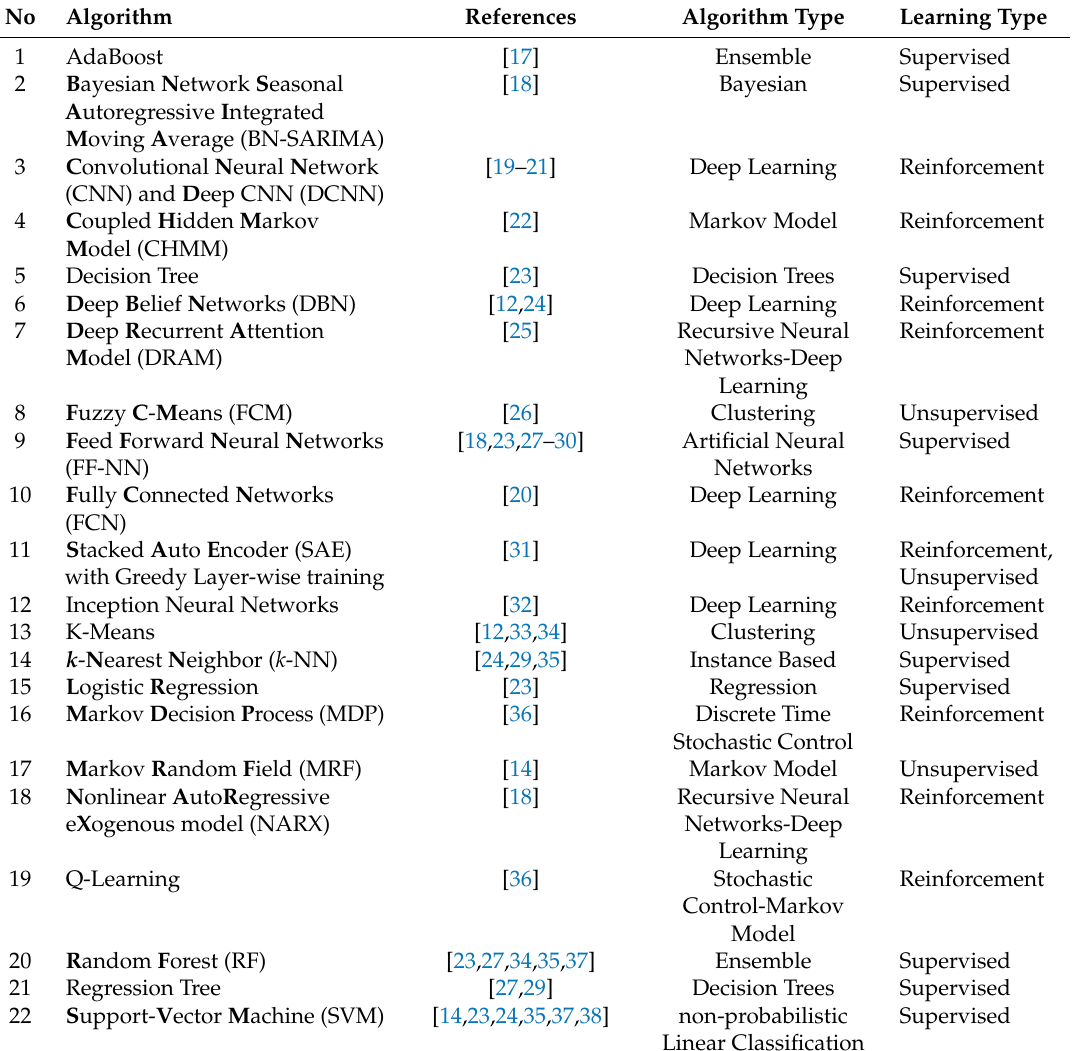
Table 1. Machine Learning algorithms in Internet of Things (IoT) smart transportation